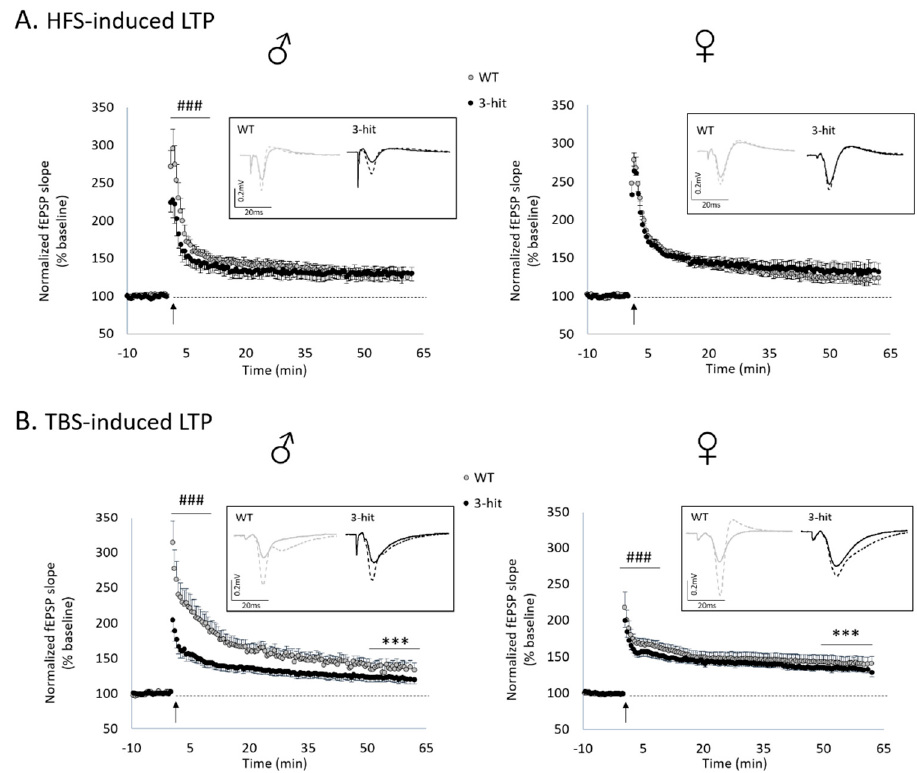
Figure 2. Functional plasticity is altered in 3-hit mice according to stimulation protocols, sex and/or the timing of potentiation. ( A ) Time-course of high frequency stimulation (HFS)-induced long-term potentiation (LTP) in WT and 3-hit mice, males (left) (WT: n = 13 slices vs. 3-hit group n = 11 slices) and females (right) (WT: n = 13 slices vs. 3-hit: n = 12 slices). ( B ) Time-course of theta-burst stimulation (TBS)-induced LTP in WT and 3-hit mice, males (left) (WT: n = 26 slices vs. 3-hit group n = 13 slices) and females (right) (WT: n = 35 slices vs. 3-hit: n = 21 slices). In inserts, examples of traces recorded in a WT and a 3-hit mouse before (filled line) and 60 min after (dashed line) the conditioning stimulation. Represented data are Mean ± SEM; non-parametric permutation test (group and time effect), group effect ***: p < 0.001 (last 15 min). ANOVA with permutation tests for STP, group effect ###: p < 0.001 (first 10 min).